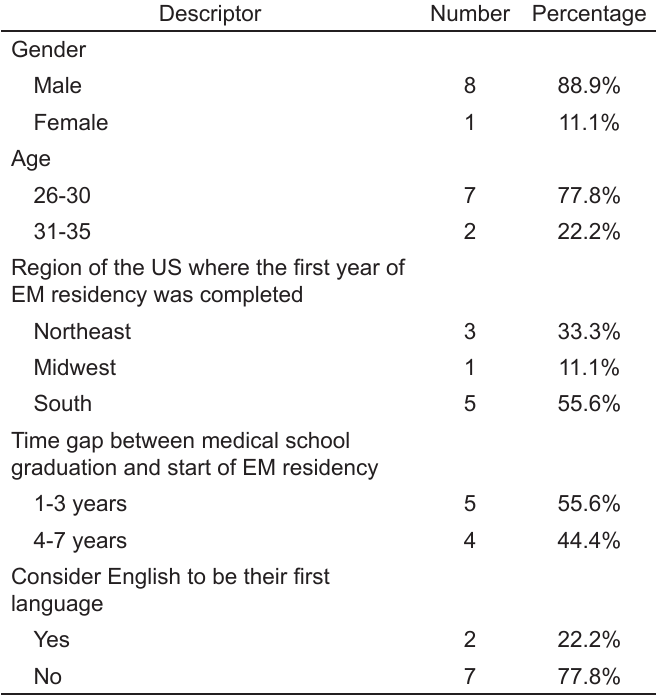
Table 2. Description of participants